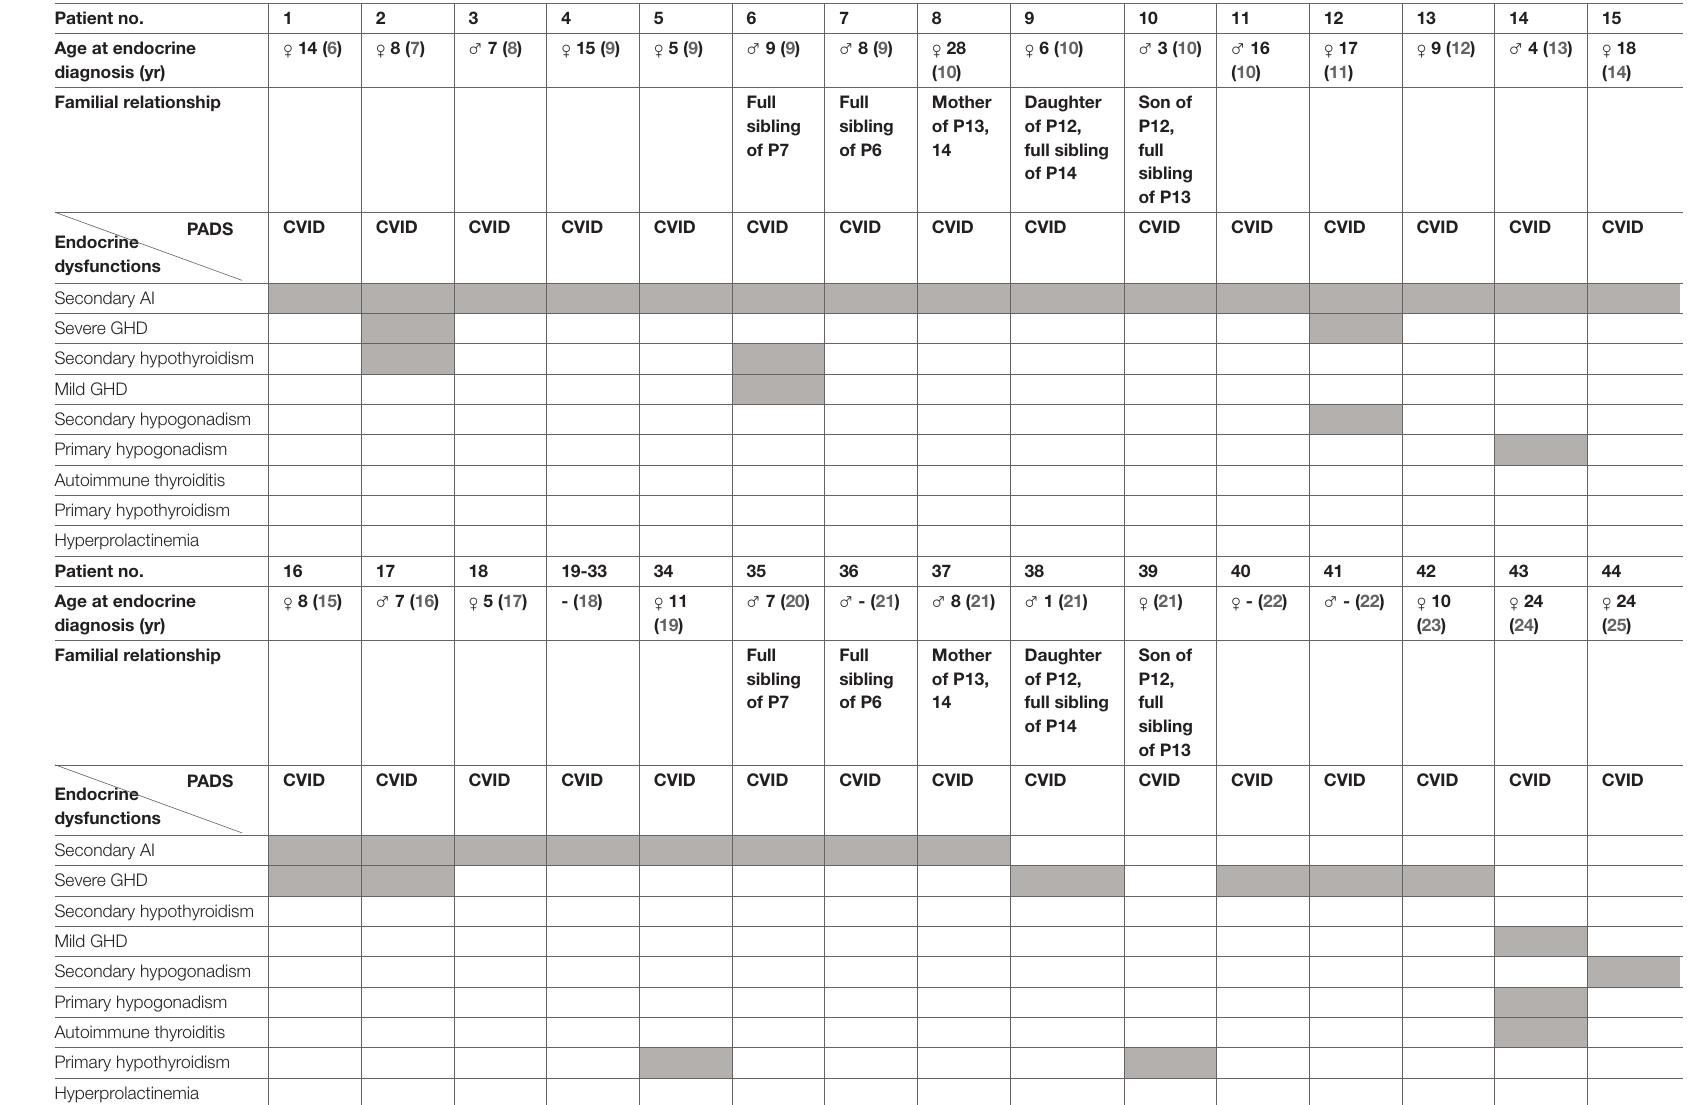
TABLE 1 | Described endocrine dysfunction in patients with CVID. Patient no.